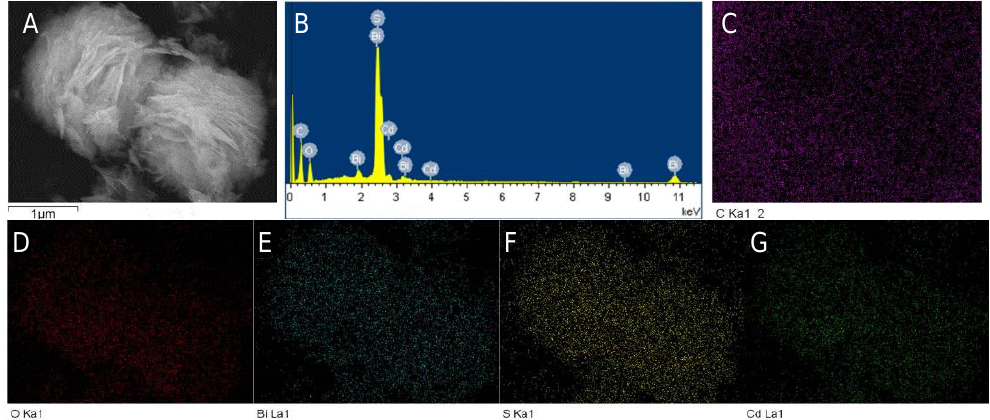
Figure 4. SEM image ( A ), the corresponding EDS spectrum ( B ) and EDS elemental mappings ( C – G ) of Bi 2 O 2 CO 3 / CdS QDs-10.